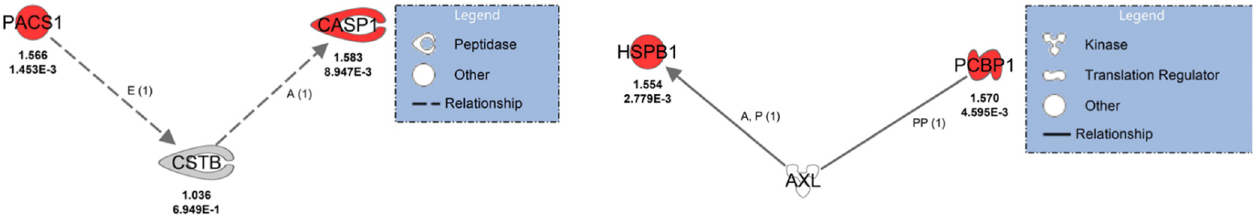
Figure 5. CSTB and AXL protein interactions from differentially expressed proteins from ZIKV- positive and negative placentas are upregulated protein interactions. Prediction legend: the inten- sity of red corresponds to higher upregulation of the protein. Upregulated proteins are phospho- furin acidic cluster sorting protein 1 (PACS1), caspase 1 (CASP1), poly(rC)-binding protein 1 (PCBP1), and small heat shock protein beta 1 (HSPB1/HSP27). The grey color means that the protein was identified but there was no significant increase in expression. A constant line means direct in- teraction, and a dashed line is indirect interaction. The letter E means expression; A means activa- tion; P means phosphorylation/dephosphorylation and PP protein–protein binding. Arrowhead means acts on, and a line without an arrow refers to binding only. Data were analyzed using IPA (QIAGEN Inc., https://www.qiagenbioinformatics.com/products/ingenuitypathway-analysis; ac- cessed 15 September 2022).